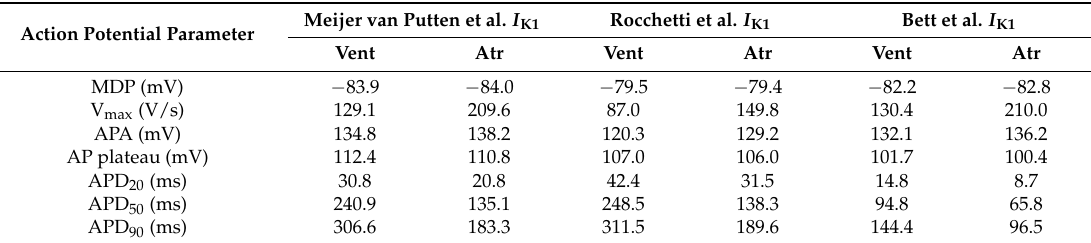
Table 4. Action potential parameters of hiPSC-CM model cell upon injection of synthetic I K1